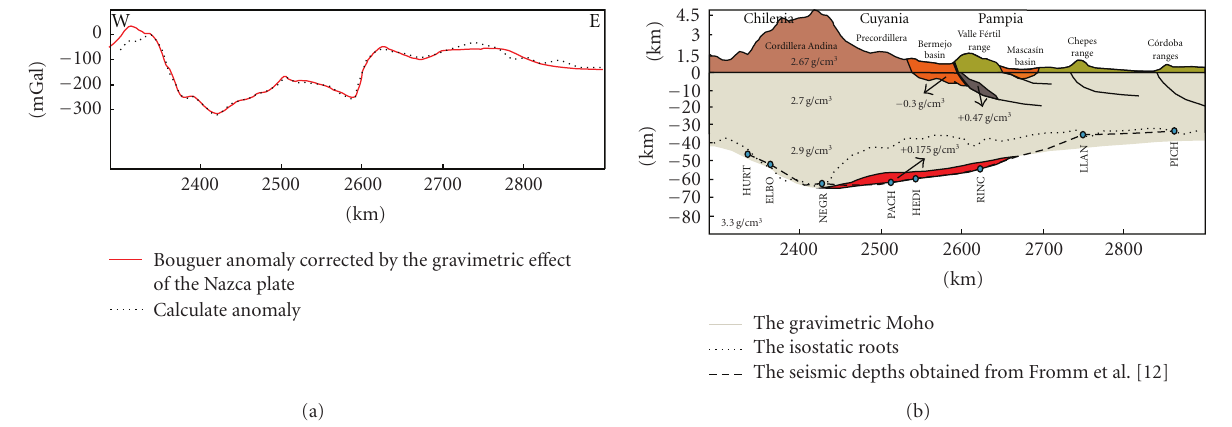
Figure 4: Crustal model where the gravimetric e ff ect adjusts to the Bouguer anomaly. This model considers an upper crust with a density 2.7g/cm 3 , a lower crust with the density of 2.9g/cm 3 , the upper mantle with a density 3.3 g/cm 3 and incorporates the inhomogeneities interpreted by Gimenez et al. [13]: the most occidental structure represents the suture zone between the Chilean and Cuyania Terranes. The Bermejo Basin is located in the central zone, with a density-contrast of − 0.3 g/cm 3 , and with a depth of approximately 10km. The incorporation of a dense positive mass below the Valley Fertil range, with a density contrast of 0.47 g/cm 3 , justifies the positive anomaly in Valley Fertil. This also represents the suture zone between the Cuyania and Pampean Terranes [13]. The sediments of the Bermejo basin, wedged below the Valley Fertil range, justify the strong gradient in the Bouguer anomaly which exists between both structures. Finally, at the base of the crust, within the Cuyania region, the layer of high density or eclogitized crust is seen in the